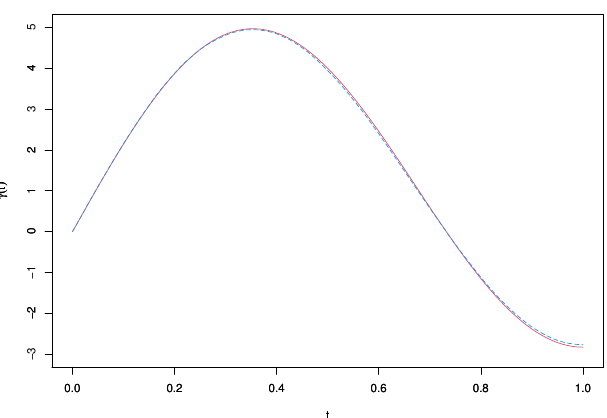
Figure 1. Simulation result of ˆ γ ( t ) when ρ = 0.2, R = 50, q = 5, σ 2 = 0.25. The solid curve denotes the true curve, the dash curve denotes its estimate.